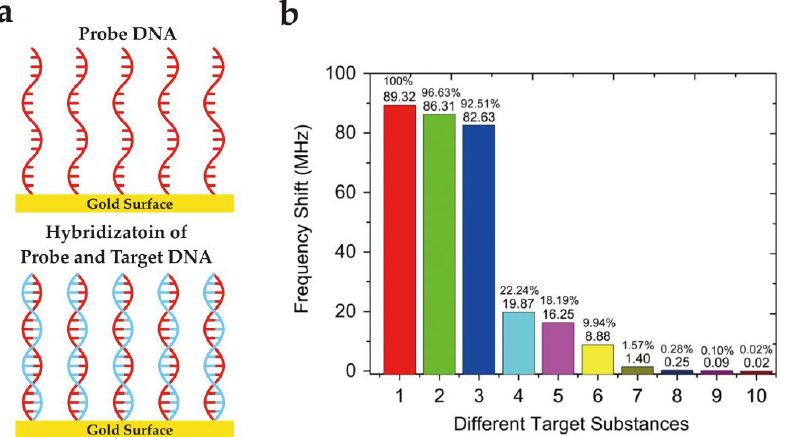
Figure 9. ( a ) Schematic representation of probe and target DNA hybridization at gold surface. ( b ) Comparison of frequency shifts for different samples. Adapted with permission from [148], copyright (2015) Elsevier. In this graph, 1: Target DNA (1 μg/mL) having 15 bases; 2: Non-target DNA (1 μg/mL) having 15 bases with one mismatch base sequence; 3: Non-target DNA (1 μg/mL) having 15 bases with two mismatch base sequence; 4 : Non-target DNA (1 μg/mL) having only 4